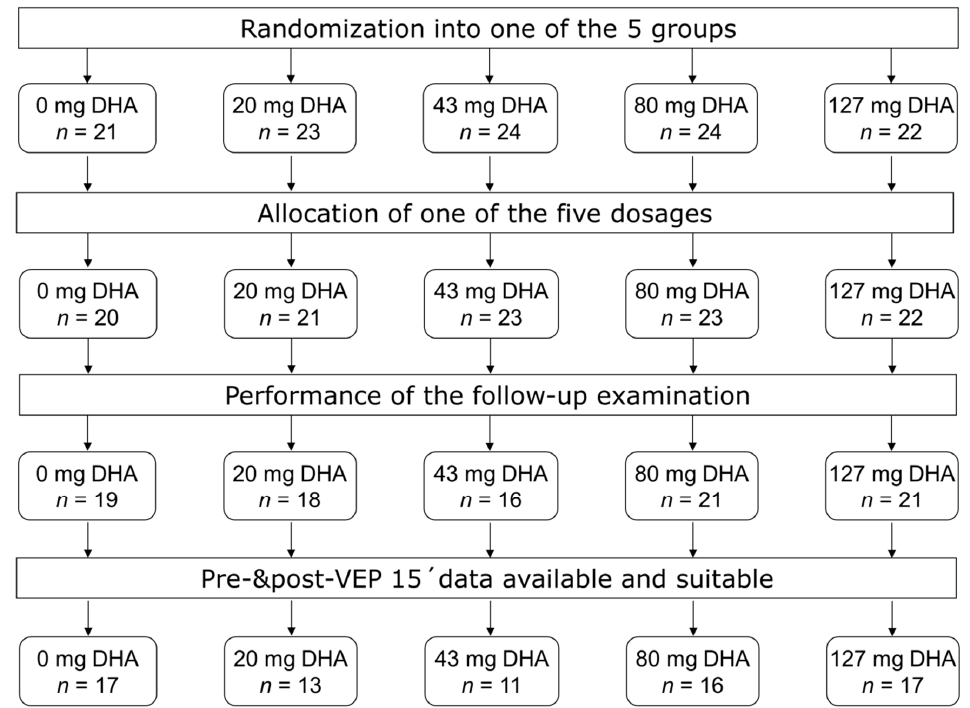
Figure 1. Participant flow chart according to CONSORT.